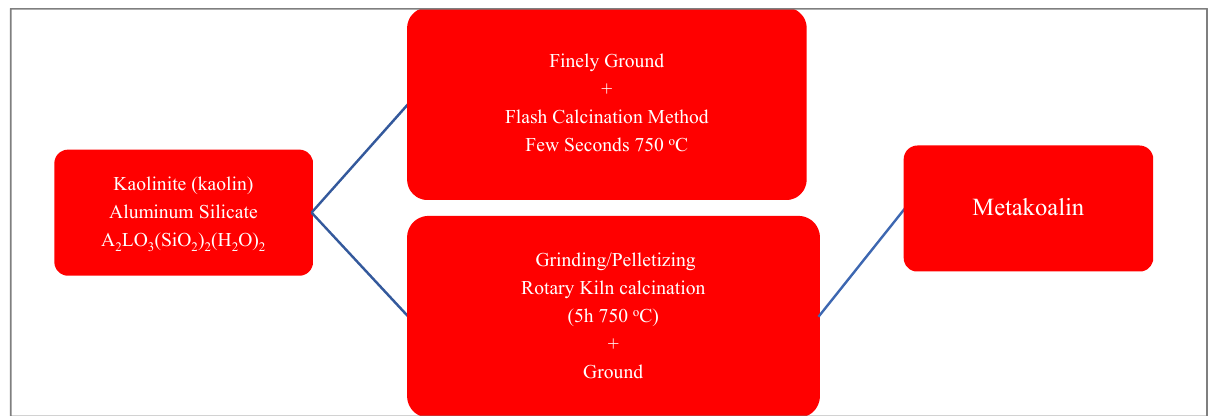
Figure 1. The production process of MTK [28].